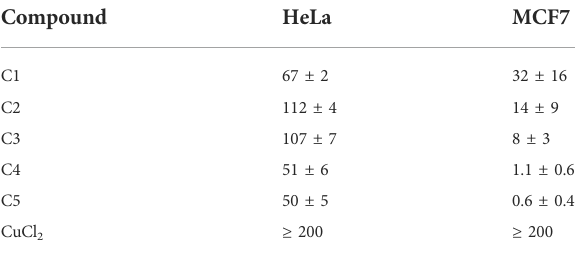
TABLE 2 IC 50 (µM) values at 24 h of complexes C1-C5 in HeLa and MCF7cellcultures,normalizedforcopper(Cu)concentration.The results shown are representative of at least three independent experiments (N ≥